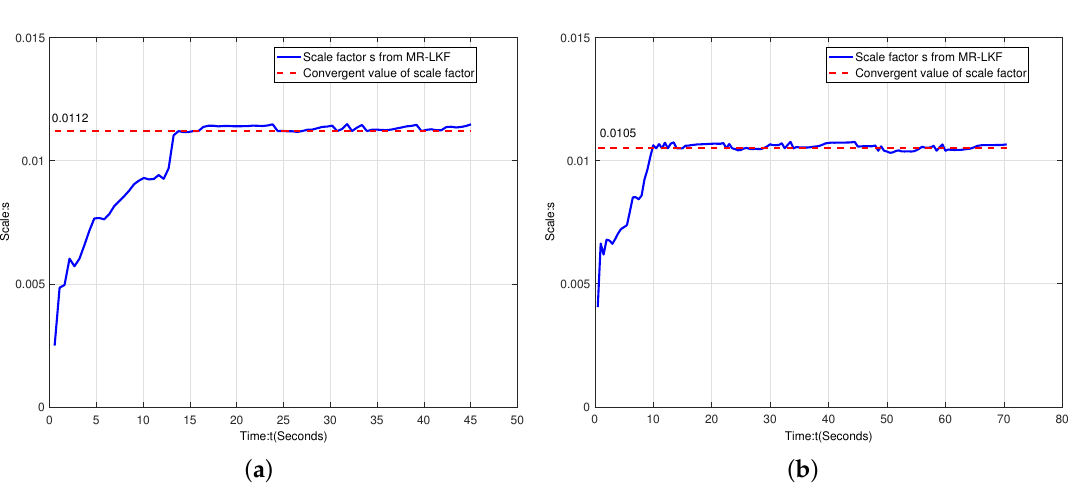
Figure 15. Scale factor analysis. ( a ) scale factor estimation for straight-line motion; ( a ) scale factor estimation for curve